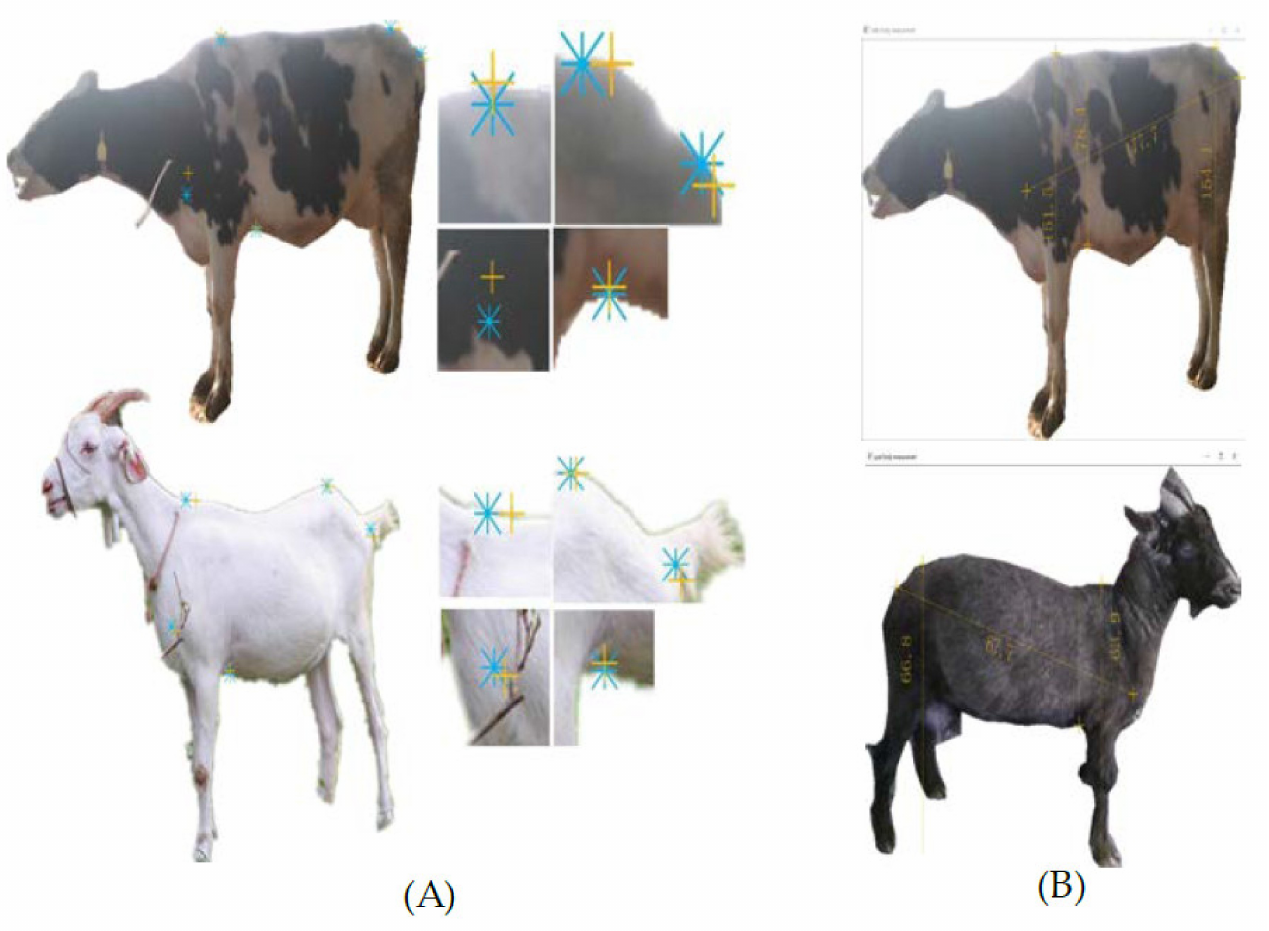
Figure 14. ( A ): The blue points are the manually marked feature points and the orange points are the feature points identified by the algorithm. From left to right and from top to bottom of the right half of Figure 14A is an enlarged image of the corresponding positions of points a, d, e, b and c in ( B ): Body size measurement